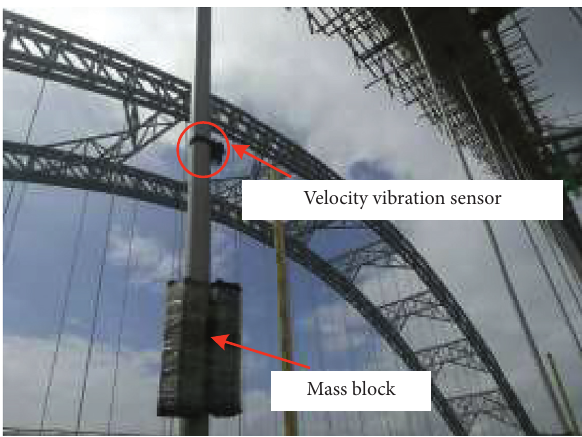
Figure 7: Field test of cable force with lumped mass.